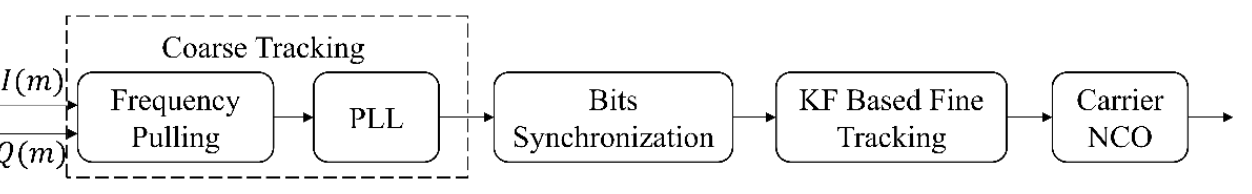
Figure 2. Traditional coarse-to-fine tracking loop structure.